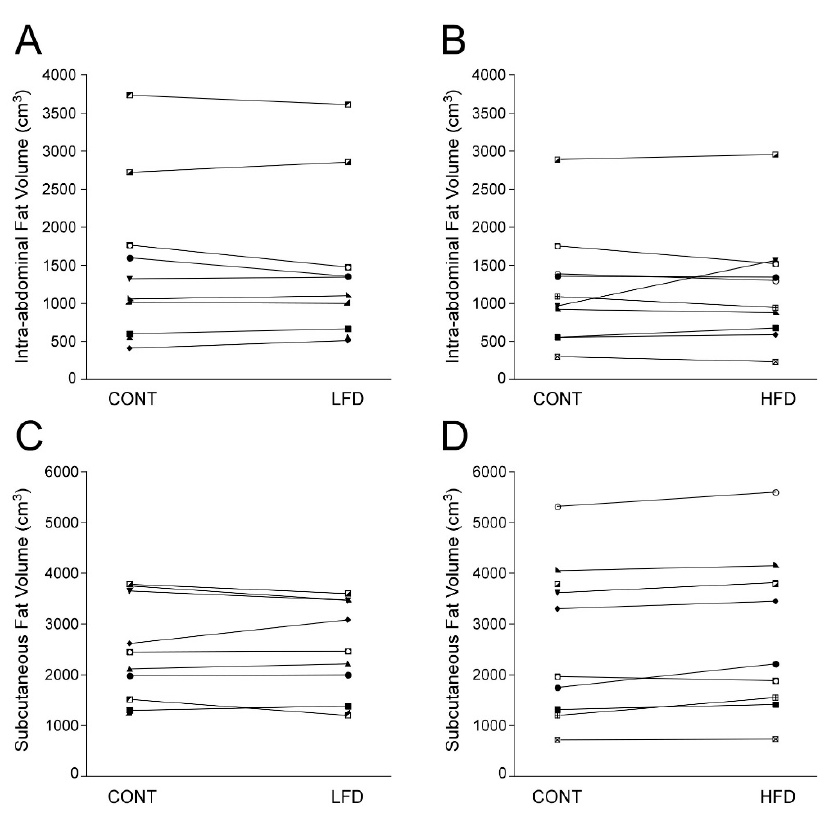
Figure 1. Effect of dietary fat on abdominal fat distribution. Compared to the control (CONT) diet, intra-abdominal fat (IAF) volume did not change on either diet (Panels A and B ). Abdominal subcutaneous fat (SQF) increased on the high fat diet (HFD) (mean (95% CI): change 156 (73, 239) cm 3 ), but did not change on the low fat diet (LFD) (panels C and D